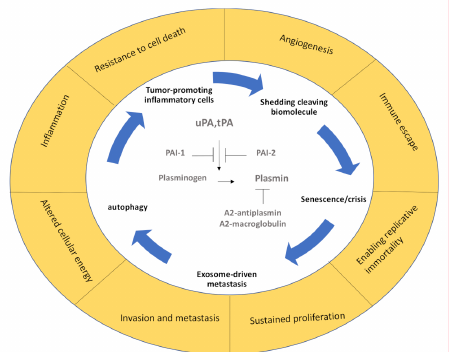
Figure 1. The fibrinolytic spiral during cancer. In the center, the main fibrinolytic factors and their endogenous inhibitors are depicted, which are surrounded by the pathogenic mechanisms they support. The outer circle summarizes the main hallmarks of cancer described by Hannahan and Weinberg [5]. PAI-1 and PAI-2: plasminogen activator inhibitor-1 and -2, tPA: tissue-type plasminogen activator, uPA: urokinase plasminogen